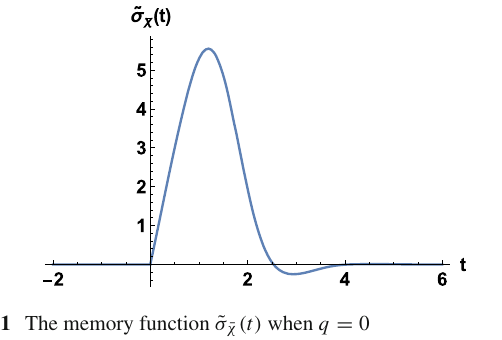
Fig. 1 The memory function ˜ σ ¯ χ ( t ) when q =